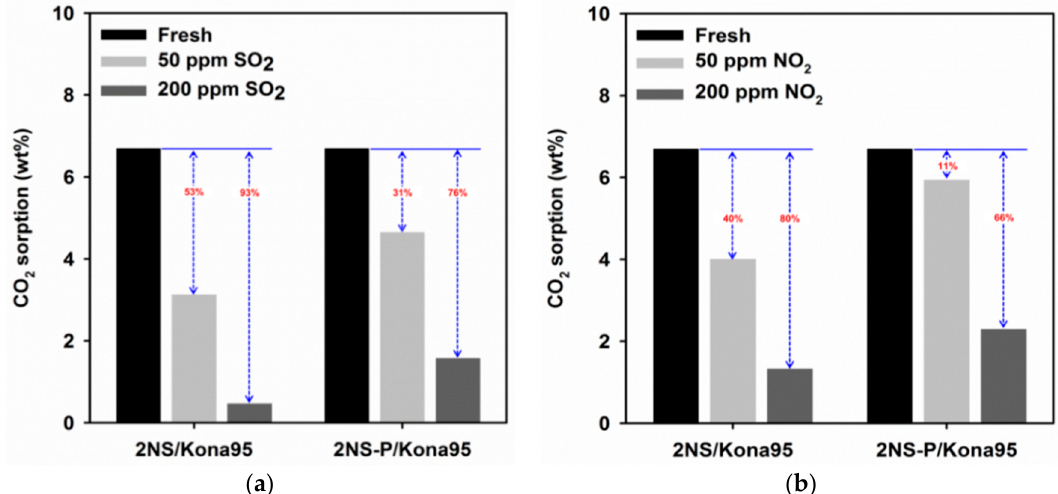
Figure 4. CO 2 sorption capacity of Kona95-supported adsorbents before and after exposure to 50 and 200 ppm of ( a ) SO 2 and ( b ) NO 2 at 110 ° C .